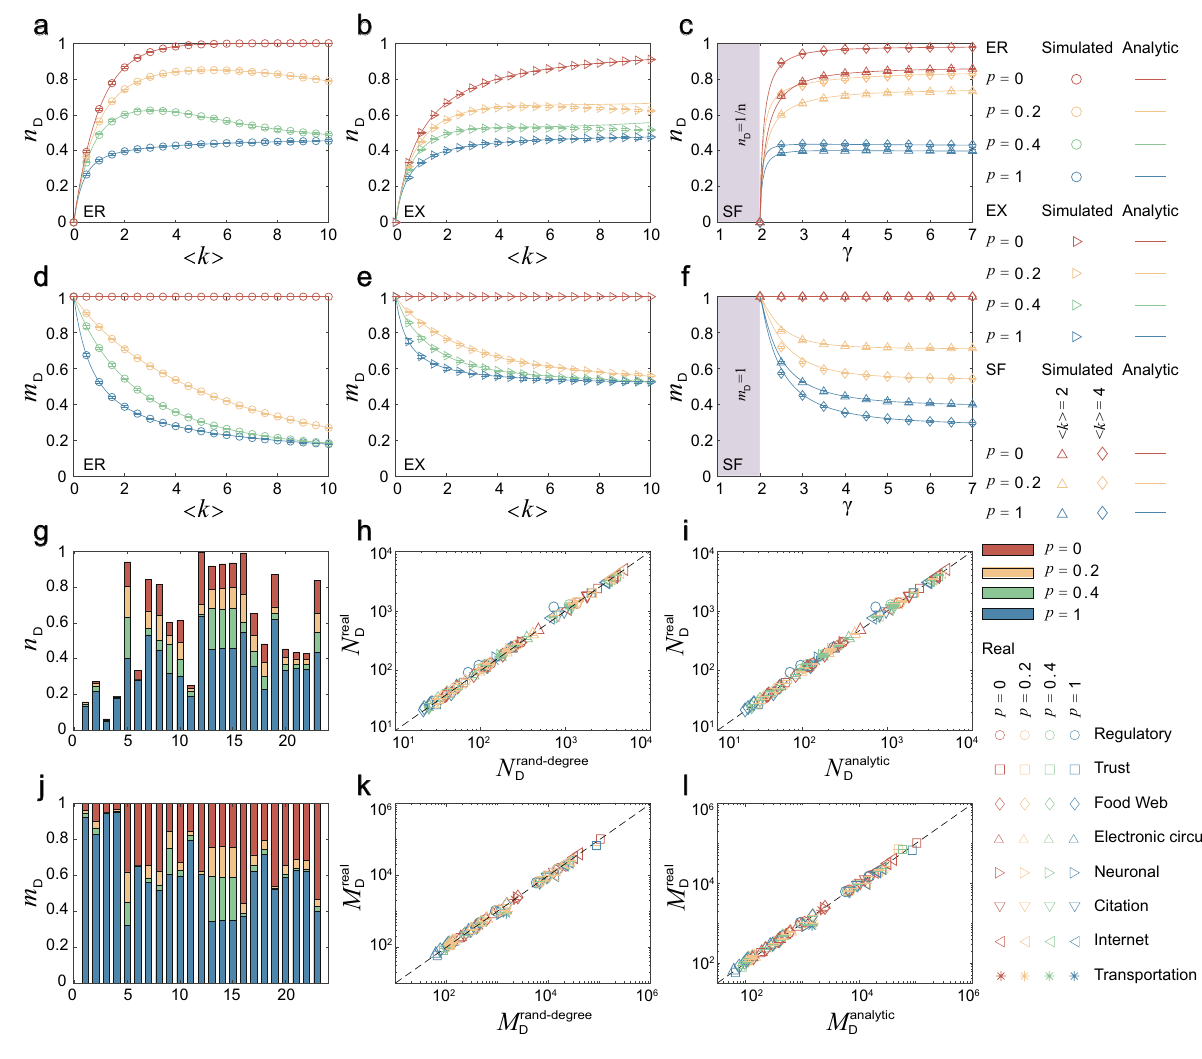
Figure 2. Controllability characteristics. The variation of n D and m D in ( a , d ) ER networks, ( b , e ) EX networks, and ( c , f ) SF networks as the function of the coupling density P , the average degree (cid:31) k (cid:30) and the power exponent γ , respectively. The results of ( g ) n D and ( j ) m D in real networks with P = 0 , P = 0.2 , P = 0.4 , and P = 1 , respectively. Numbers refer to the network indices in Table 1. The results of ( h ) N rand − degree D obtained from the degree-preserving randomized version of the real networks, compared with the real results, respectively. The theoretical predictions of ( i ) N real results, respectively. All the numerical results are obtained by averaging over 100 independent network